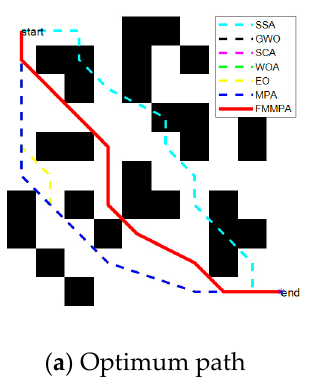
Figure 7. Experimental results for map 1.